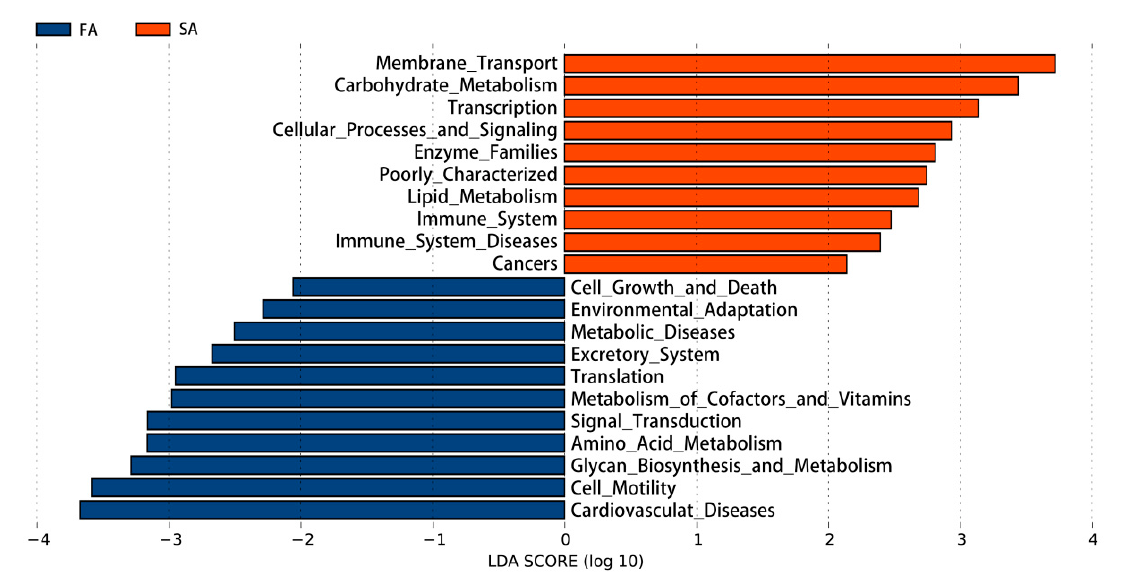
Figure 6. Differences in gut microbial function prediction between FA and SA treatments. SA: slow-growing dual-purpose chickens fed ad libitum, FA: fast-growing breed fed ad libitum.